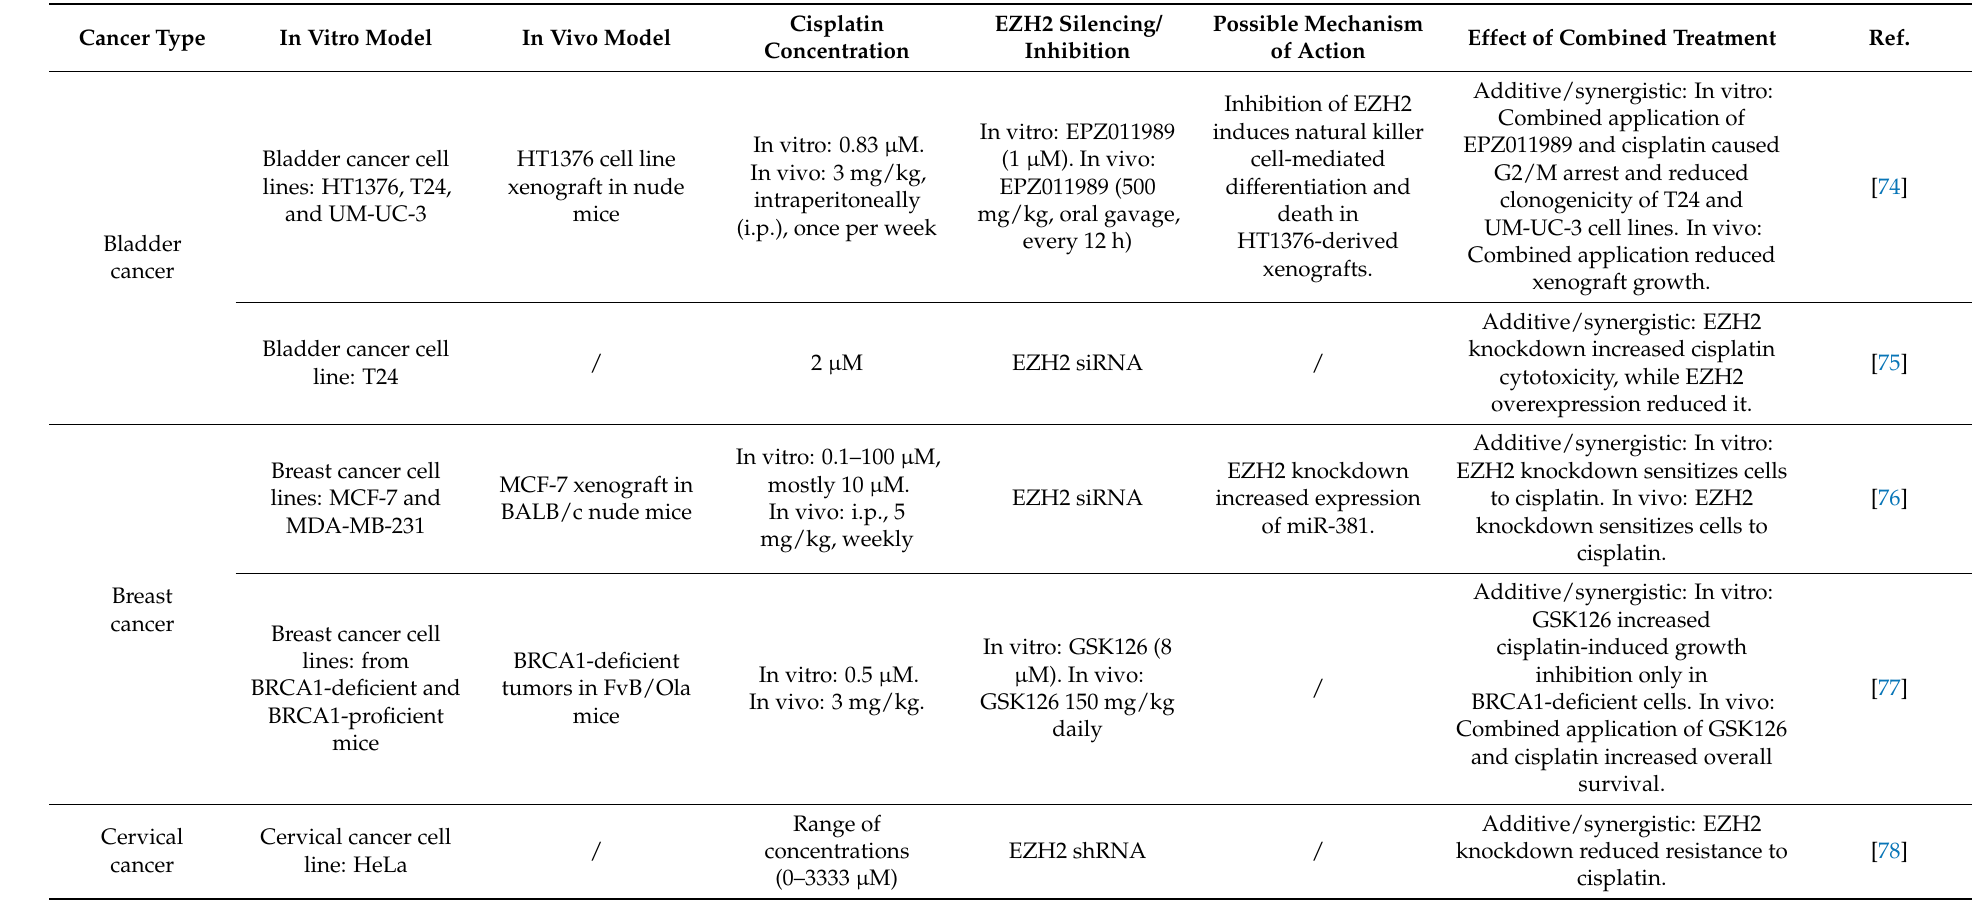
Table 1. Overview of preclinical studies of cisplatin combined with EZH2